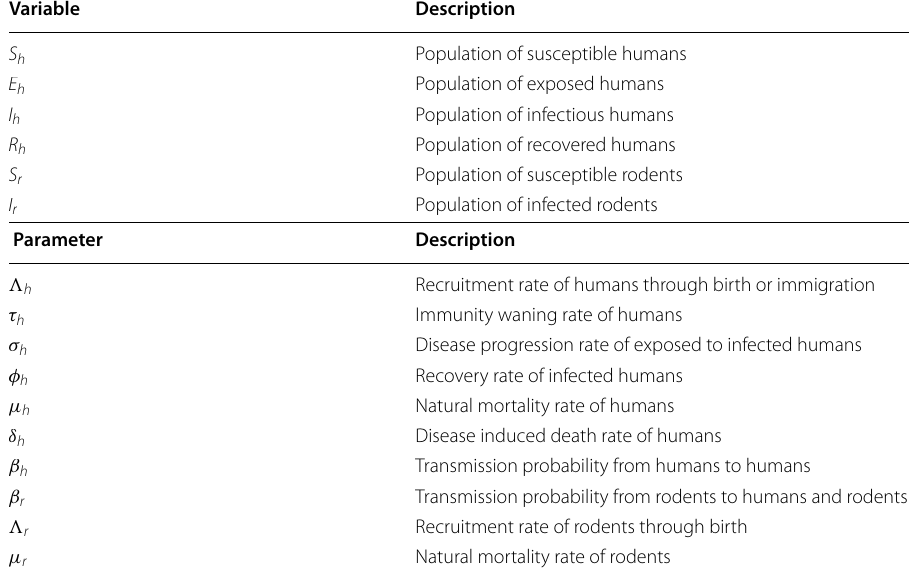
Table 1 Description of the variables and parameters of the Lassa fever model (1)